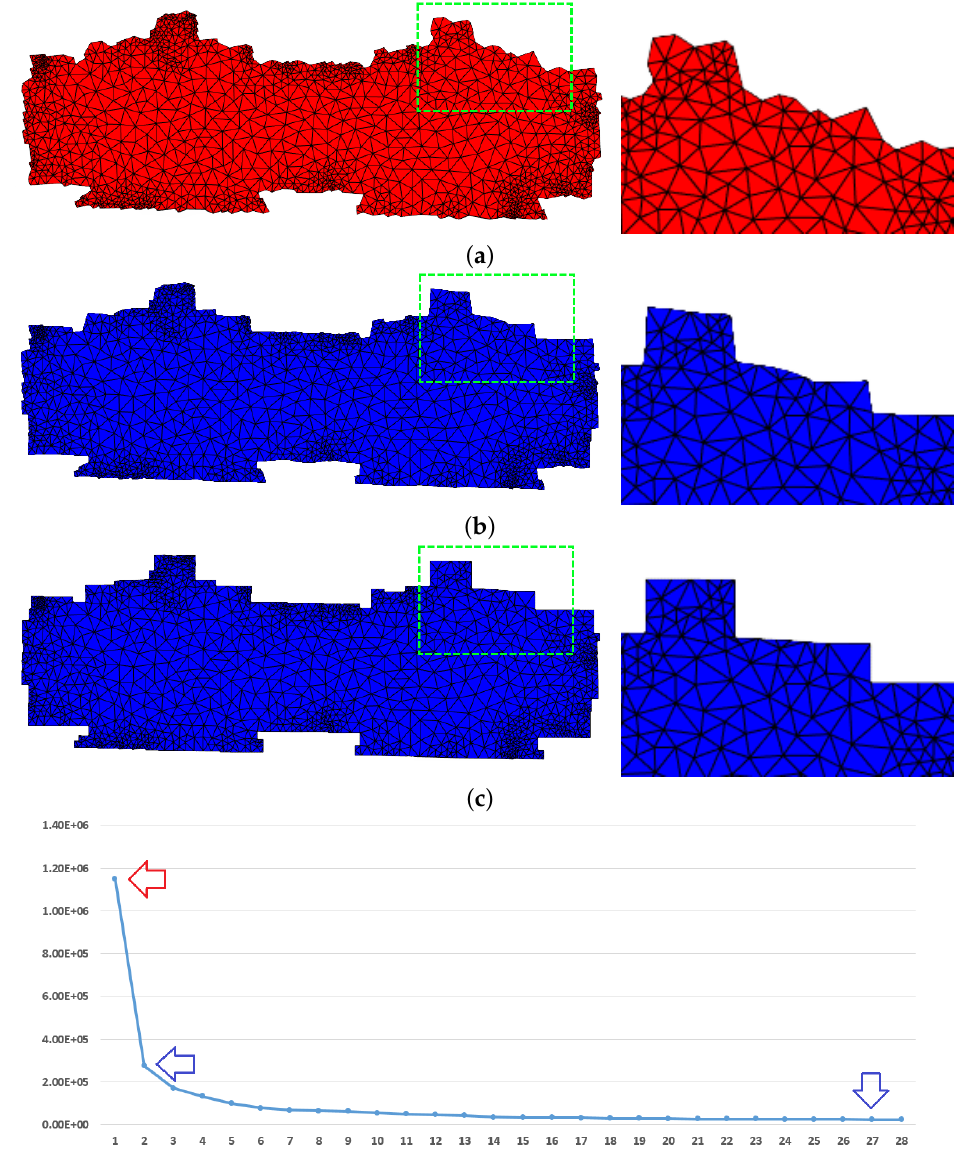
Figure 7. Deformation energy minimization aligning to the nearest axes on a large contour. The right side of the first three rows is the close-ups of the area in the green rectangles on left. ( a ) The input jaggy contour triangle mesh has 1424 vertexes, 2508 faces and 338 boundary edges. The initial energy is 1,150,510 ( b ) The contour mesh at the 2nd iteration with energy of 170,687. ( c ) The contour mesh at the 27th iteration with energy of 23,589. ( d ) The energy minimization curve from the first iteration to the last one. It drops rapidly in the first few iterations and stops